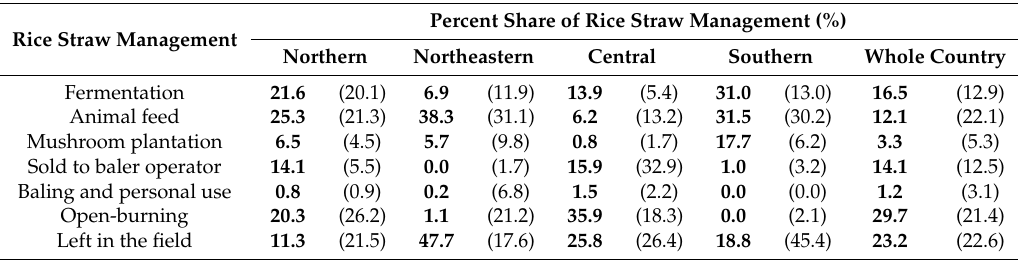
Table 2. Percentage share of rice straw management derived from the questionnaire survey.